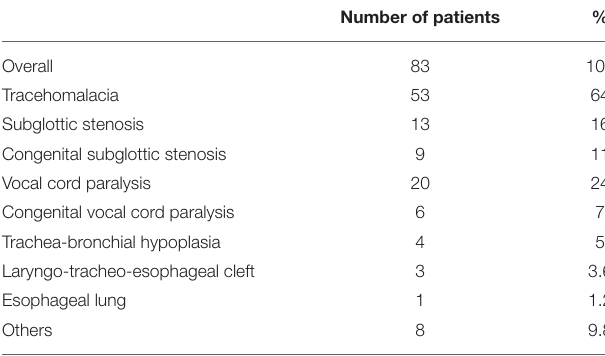
TABLE 1 | LTA distribution.